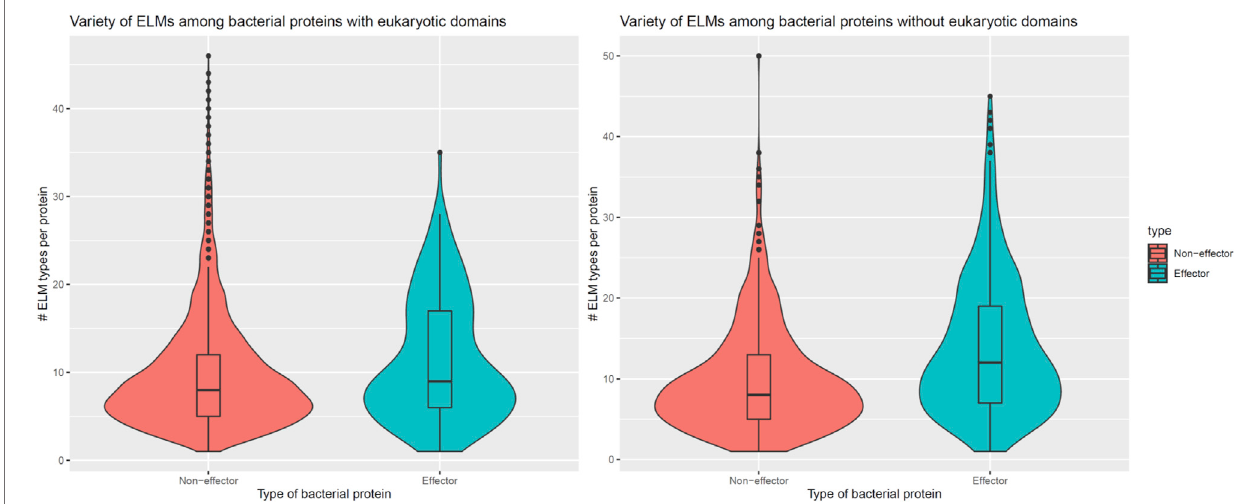
compared to 8 ELM classes per non-effector protein. Right: In the absence of eukaryotic-like domains or among proteins without Pfam domains, effectors encode 12 ELM classes per protein, a much higher variety (Wilcoxon test, two-tailed p < 2.2 * 10 − 16 ) compared to 8 ELM classes per non-effector protein. ELM (cid:2) eukaryotic linear motif.